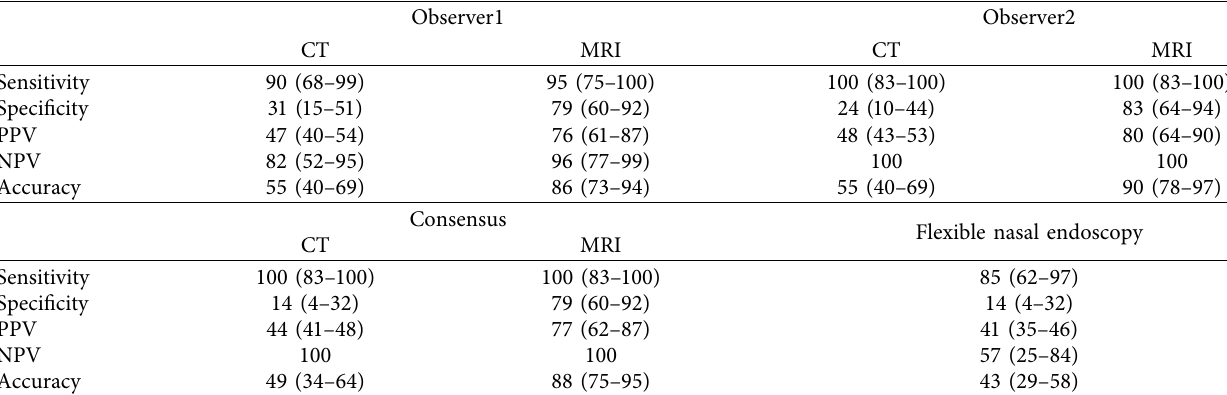
Table 4: Diagnostic performance of CT and MRI for Observer1, Observer2, consensus, and flexible nasal